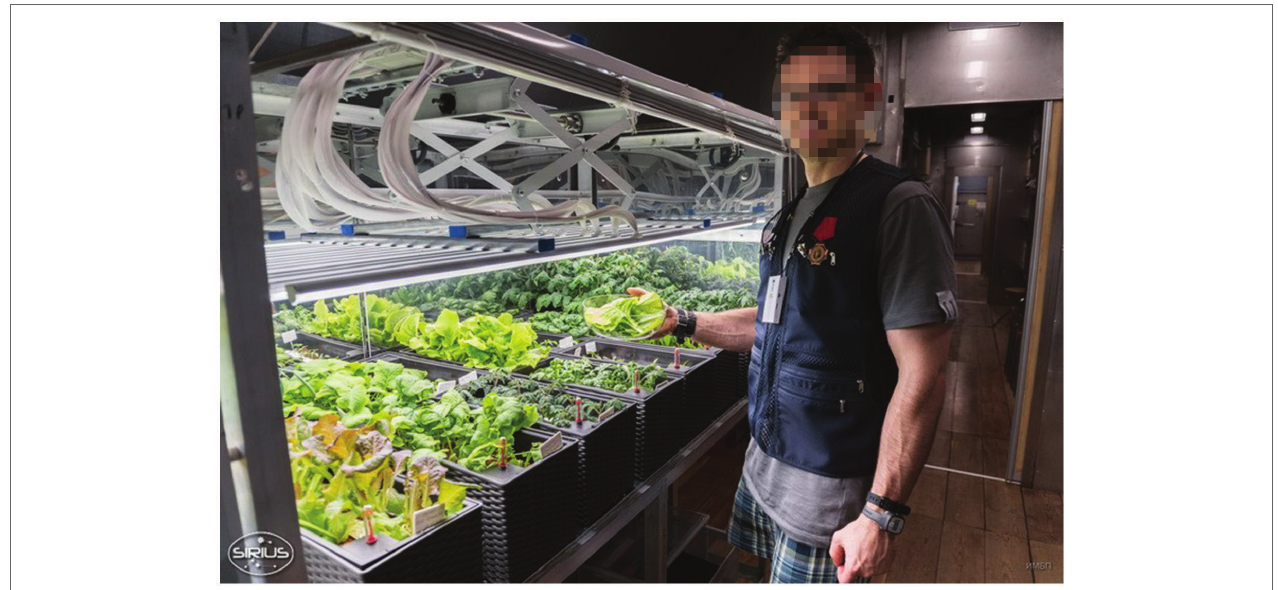
FIGURE 5 | A participant of the SIRIUS-19 with the onboard greenhouse. Copyright (2019) by the Institute of Biomedical Problems, Russian Academy of Sciences reprinted and adapted with